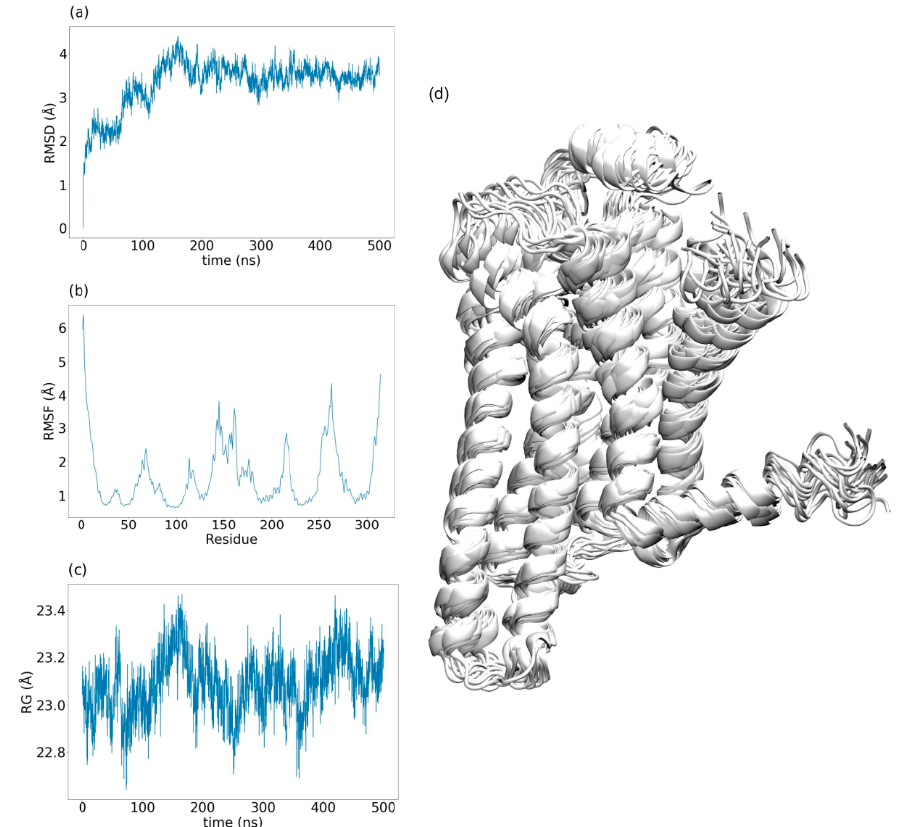
Figure 4. Example of di ff erent parameters analyzed in a 500 ns-long MD simulation of the A 2A receptor (A 2A R). ( a ) Root mean square deviation (RMSD) profile taking as reference the first frame of the simulation, which is superimposed to the rest of the frames. RMSD values (i.e., structural di ff erences with respect to the reference frame) increase over the simulation time until the system reaches a stable conformation after 100 ns. ( b ) Root mean square fluctuation (RMSF) profile displaying the values of all the alpha carbons in the protein. Higher RMSF values correspond to flexible loops, while lower ones belong to transmembrane helices, where residues are stabilized by the secondary structure. ( c ) Radius of gyration (RG) profile where the RG fluctuates around the same value during the simulation, indicating that the system does not su ff er any big change in compactness. ( d ) Superimposition of 25 representative frames of the simulated receptor. The relative mobility of loop regions contrasts with the rigidness of the transmembrane helices.